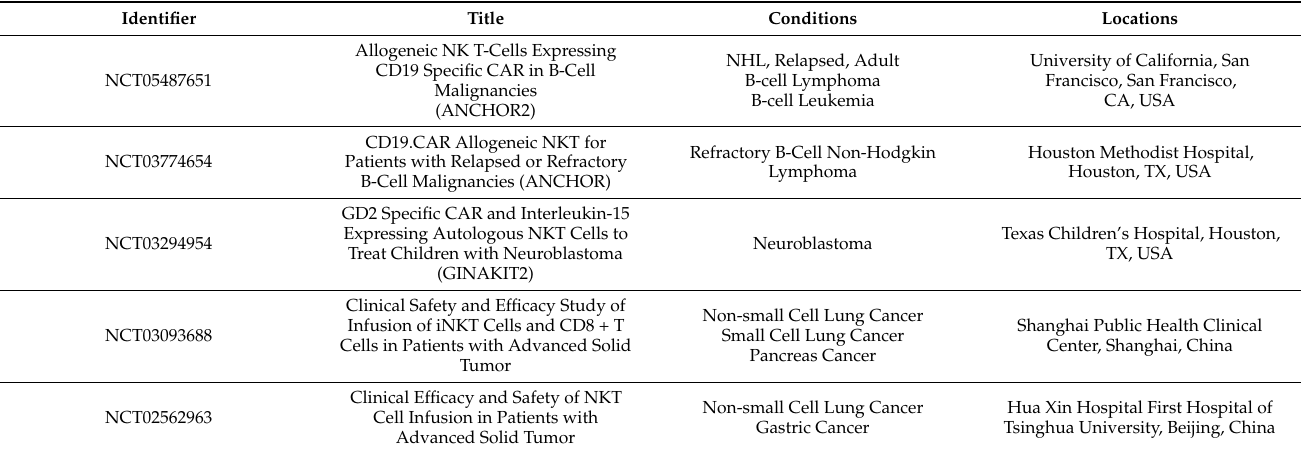
Table 1. Ongoing clinical trials of NKT cell-related immune therapy